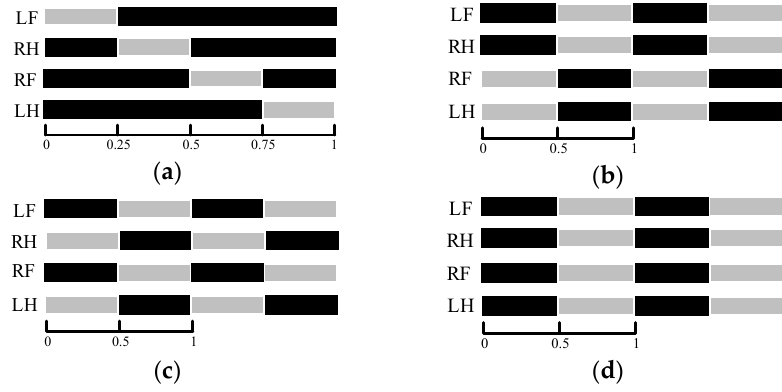
Figure 6. Turtle gaits (The black arrow indicates that the leg is in transfer phase). ( a ) The tripod walking gait (TPWG); ( b ) the trotting walking gait (TTWG); ( c ) the synchronous sliding gait with two legs (SSGTL); ( d ) the synchronous sliding gait with four legs; ( e ) the rotary sliding gait with zero radius.